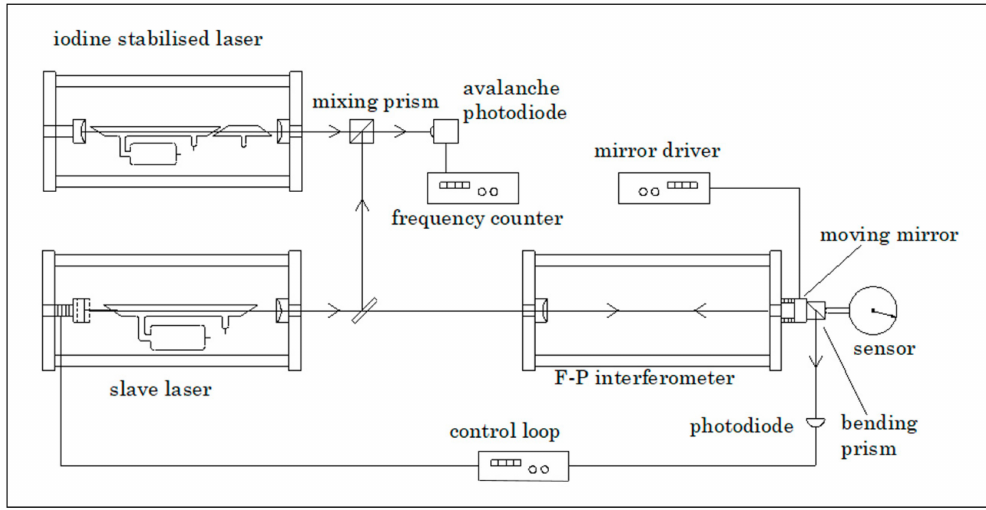
Figure 8. Overview of the metrological Fabry–P é rot interferometer set-up. Courtesy of S. Wetzels. The slave-laser frequency must be modulated in order to find the appropriate